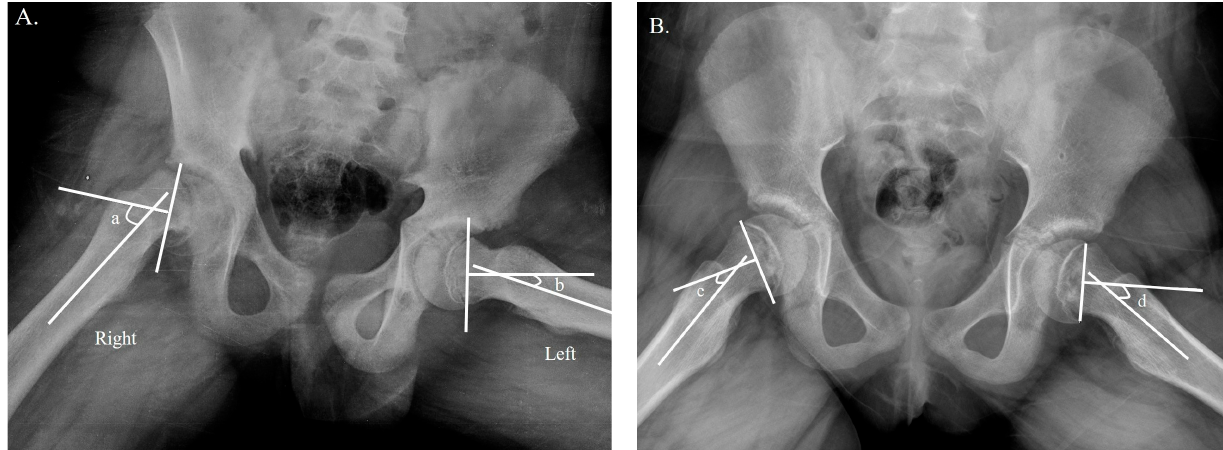
Figure 1. Determination of slip severity. ( A ) Measurement of the Southwick angle difference on a frog-leg lateral radiograph in unilateral SCFE. The slip angle difference was calculated by subtracting b from a; in the example above, the difference was between 30 and 50 degrees, which was classified as moderate slip [27]. ( B ) Measurement of the Southwick angle in bilateral SCFE on a frog-leg lateral radiograph, which uses 12 degrees as the control angle [28]. The slip angle difference was calculated by subtracting c from d; in the example above, both sides were less than 30 degrees, which was classified as mild slip.